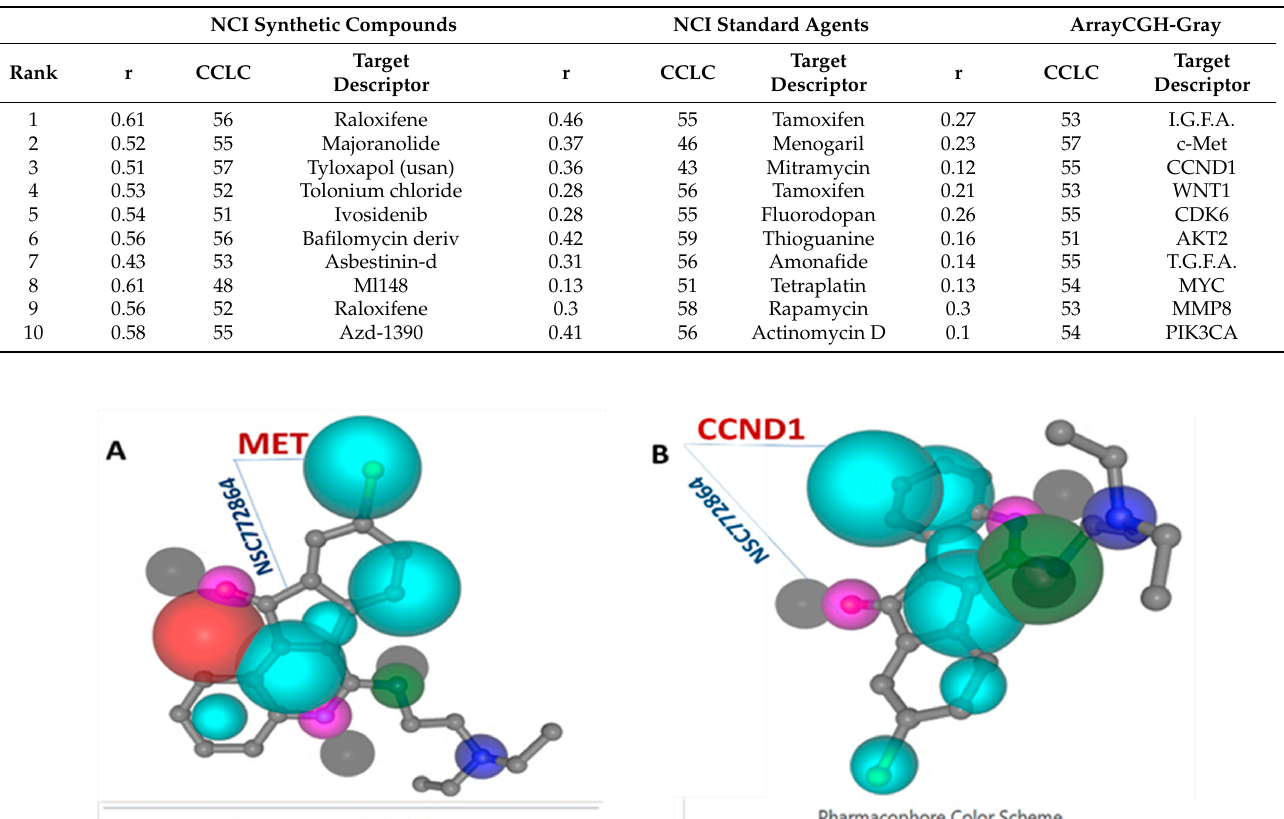
Table 1. Correlation of SJ3 with NCI synthetic compounds and standard anticancer agents sharing similar anticancer fingerprints and mechanisms.